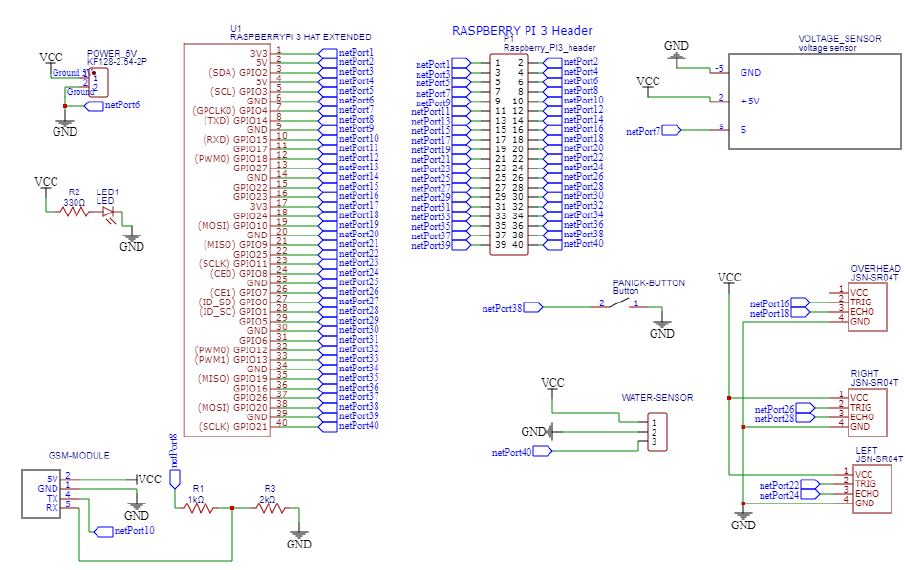
Figure 10. Schematic diagram of the proposed